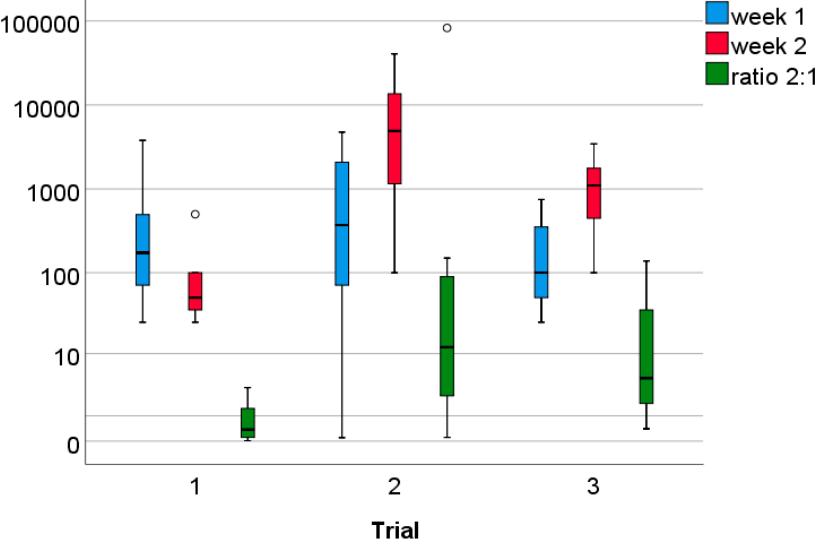
Figure 6. Parasitic burden in the three trials in week 1 and week 2 (coccidial oocysts / g faeces), as well as ratio 2:1 (number of oocysts at the sampling in the second week of fattening, divided by the number of oocysts / g faeces at the sampling in the first week), regardless of ground floor type. Due to very large outliers, values are depicted on the logarithmic scale; n = 8 pens per trial.